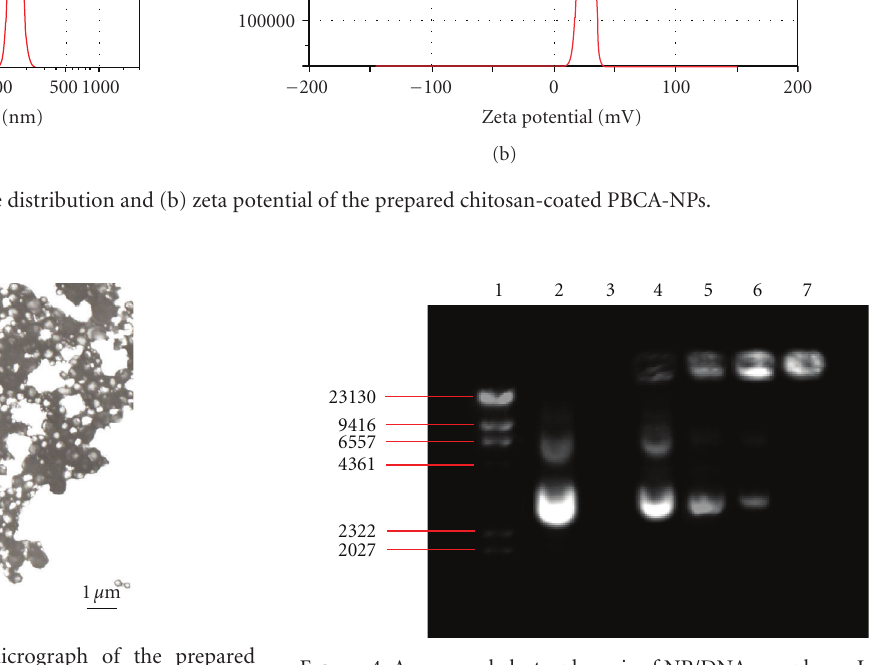
Figure 4: Agarose gel electrophoresis of NP/DNA complexes. Lane 1: DNA molecular weight marker; lane 2: naked plasmid DNA; lane 3: chitosan-coated PBCA-NPs; lanes 4–7 correspond to DNA